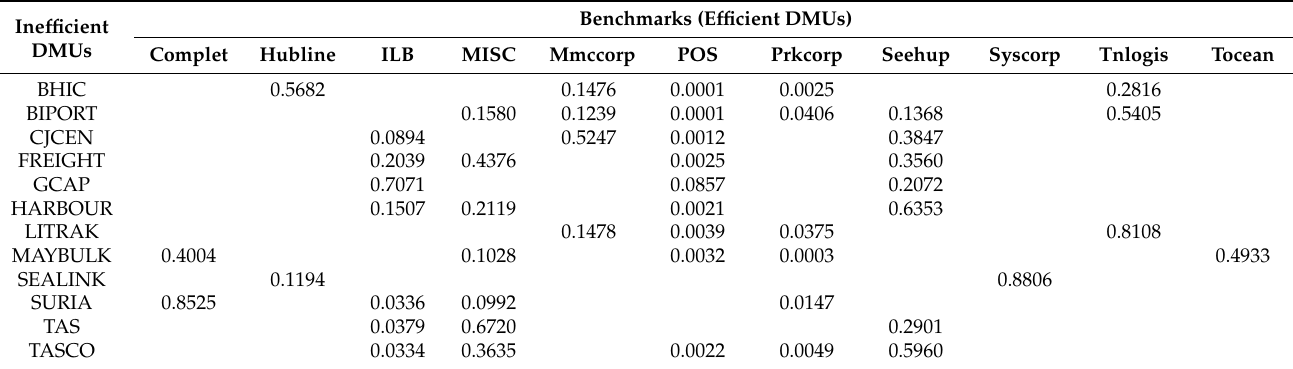
Table 4. Benchmarks for inefficient DMUs.